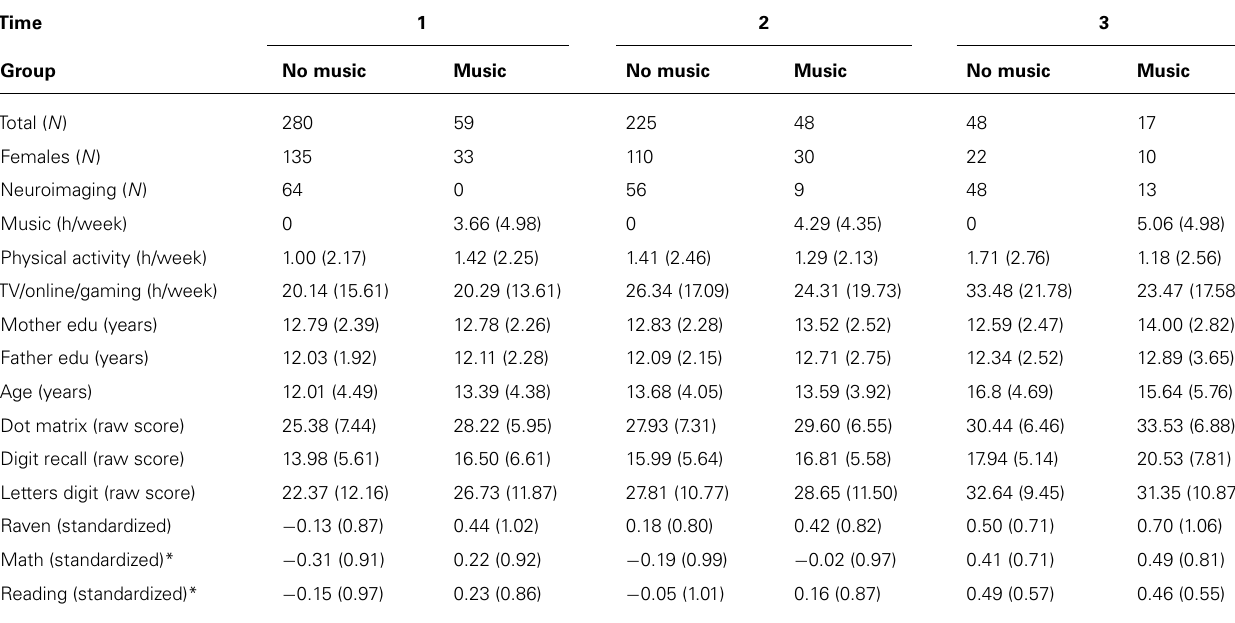
Table 1 | Sample sizes and descriptive data for the variables included for each time point, with standard deviations in